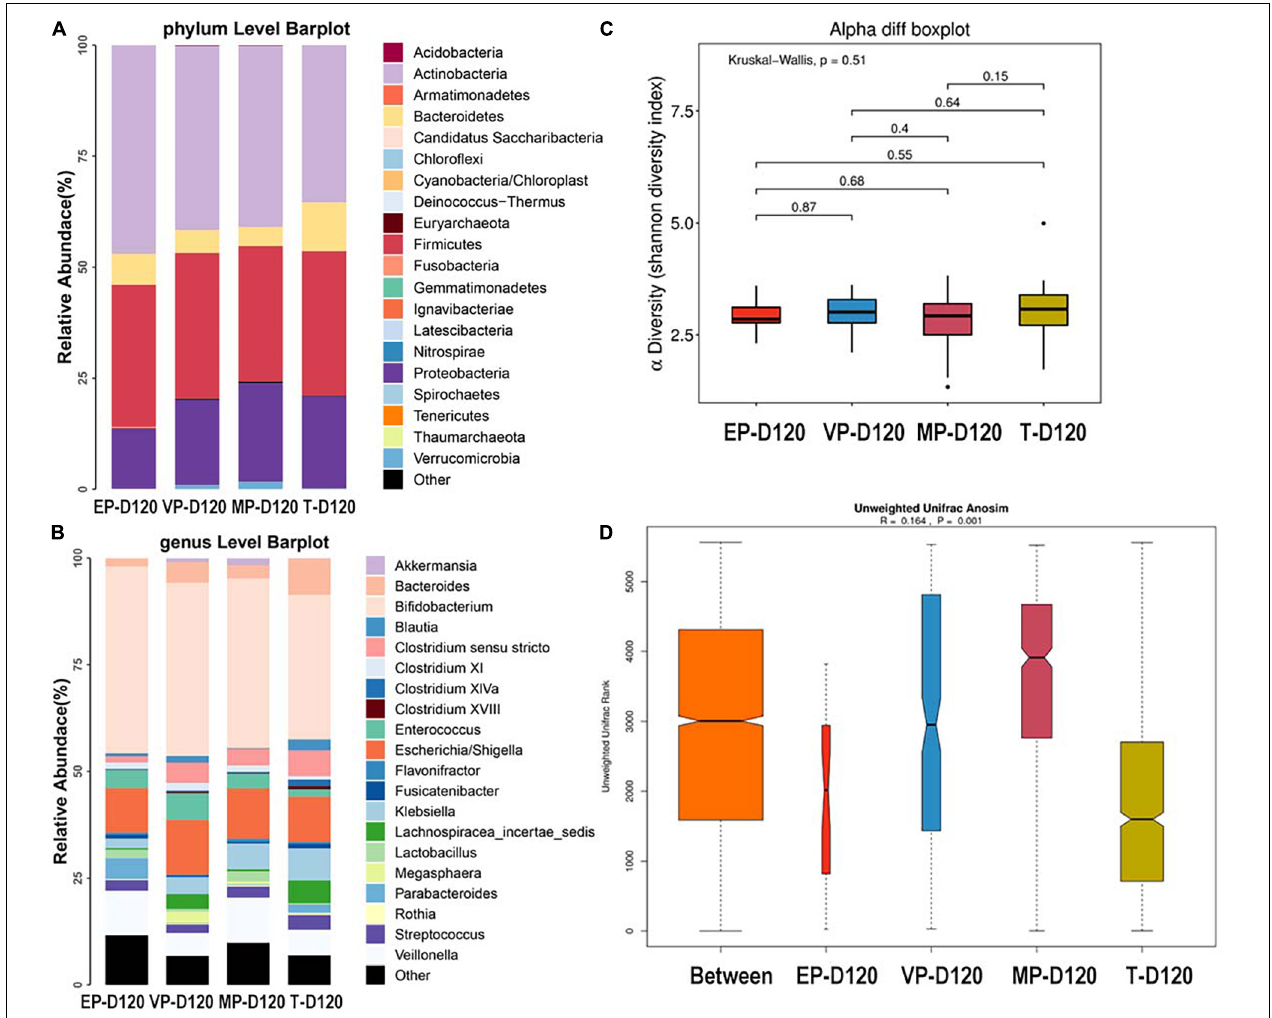
FIGURE 5 | The composition of gut microbiota from neonates with different gestational ages at 120 days after birth. EP, extremely preterm; VP, very preterm; MP, moderate to late preterm; T, full-term. (A) Comparison of abundance at phylum level. (B) Comparison of abundance at genus level. (C) Shannon diversity index of α diversity. (D) Anosim analysis of β